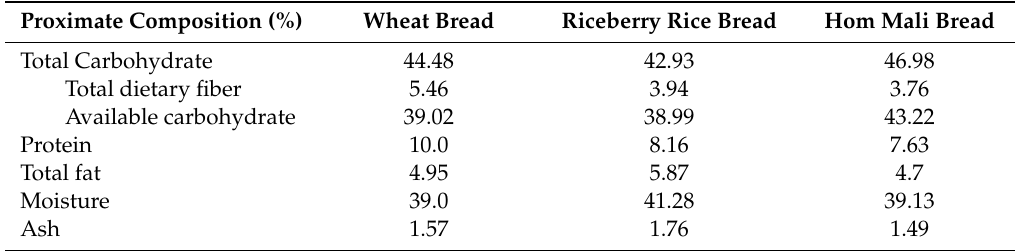
Table 1 . Composition and nutritional contribution of the test breads .